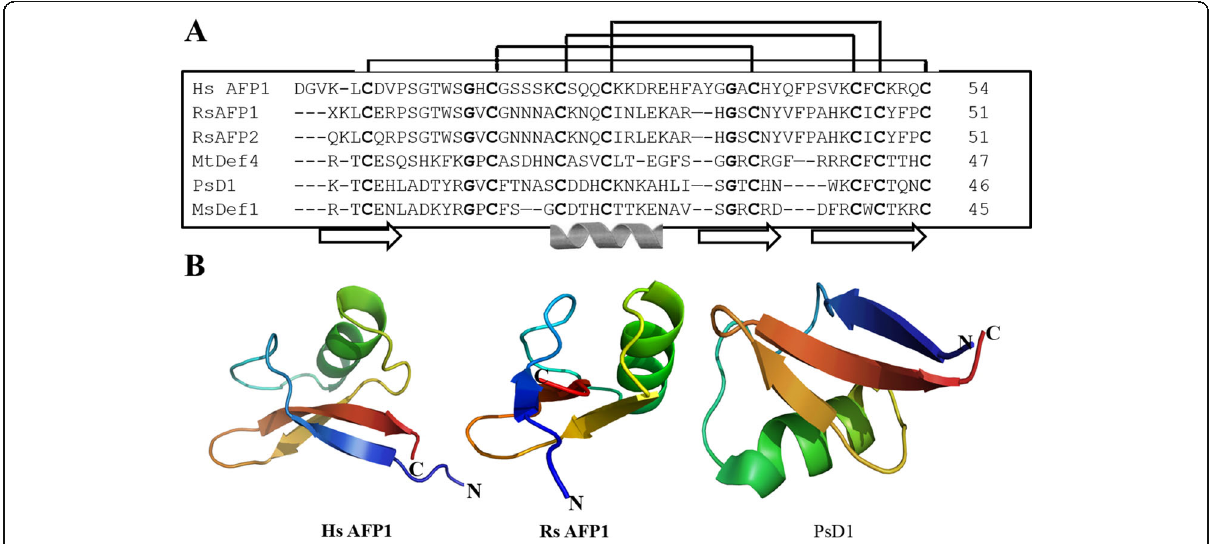
Fig. 3 Overlapping and tertiary structure of the different types of defensins. a Bold letter in the sequence represents conserved position throughout the different types of defensins from different families plants, conserved cysteine which involve in the formation of disulfide bridge, --dash line placed between sequence to denotes variability in length in the process of alignment of sequence and arrow and helical structure represents the presence of α -helix and β -sheet of different segments of sequence. b Tertiary structure of different type of